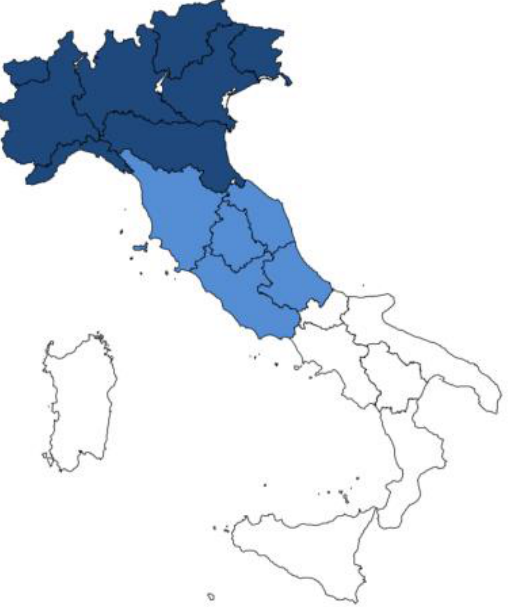
Figure 1. Geographical subdivision of Italy in three areas: North (dark blue), Centre (blue), and South (white).